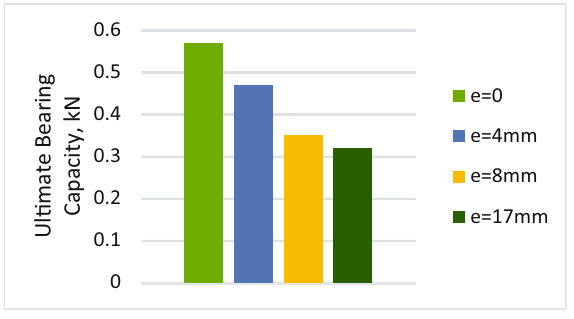
Figure 12: Load – settlement ratio relationship at D s = 1.5 B .